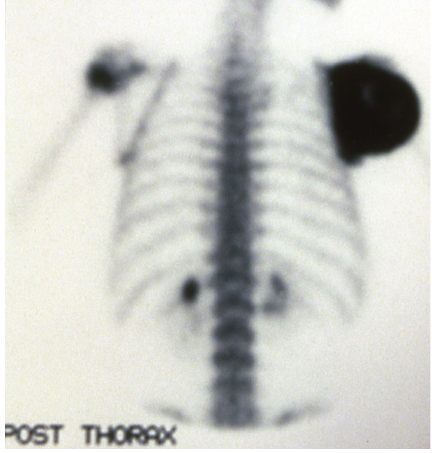
Figure 3: 99m Tc-MDP bone scintigraphy. Posterior aspect.